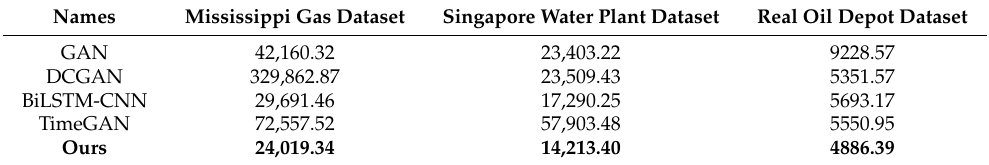
Table 3. Comparison of similarity between generated data and seed data (Manhattan